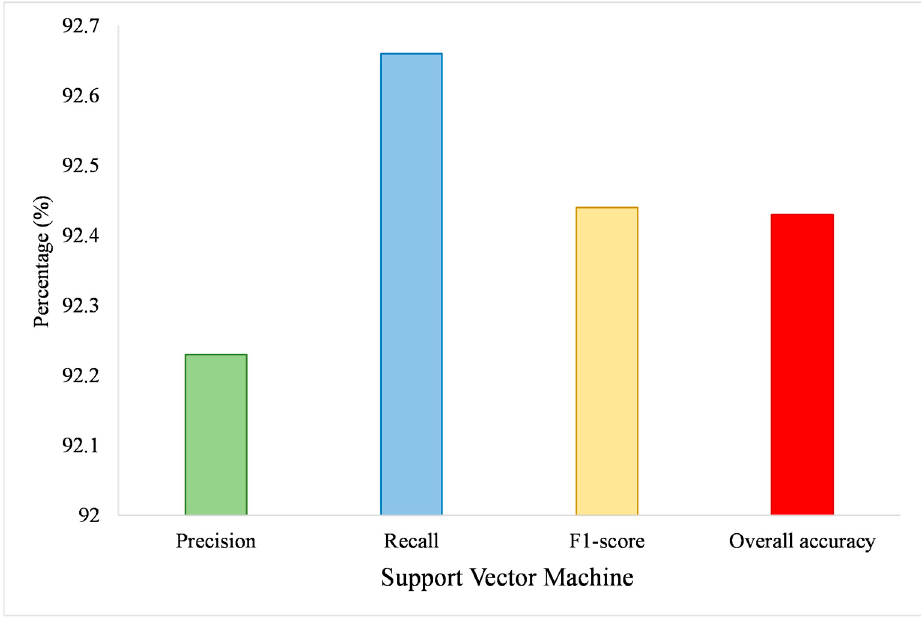
Figure 13. Comparison of the prediction accuracy of the support vector machine application in the Three Gorges Reservoir area.